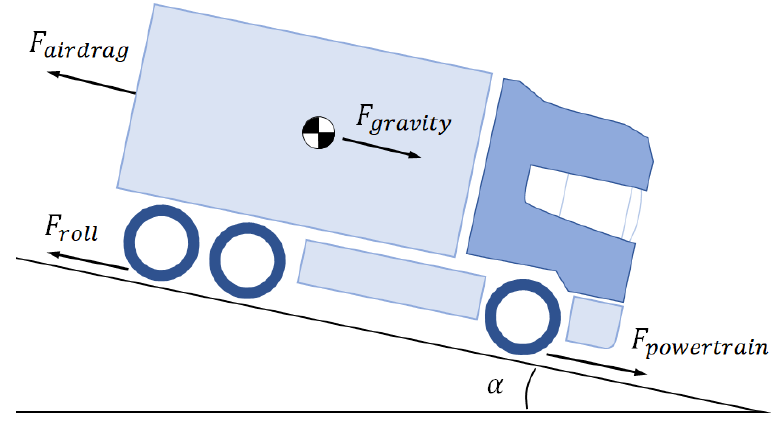
Figure 1. The longitudinal forces for an electric truck in motion .